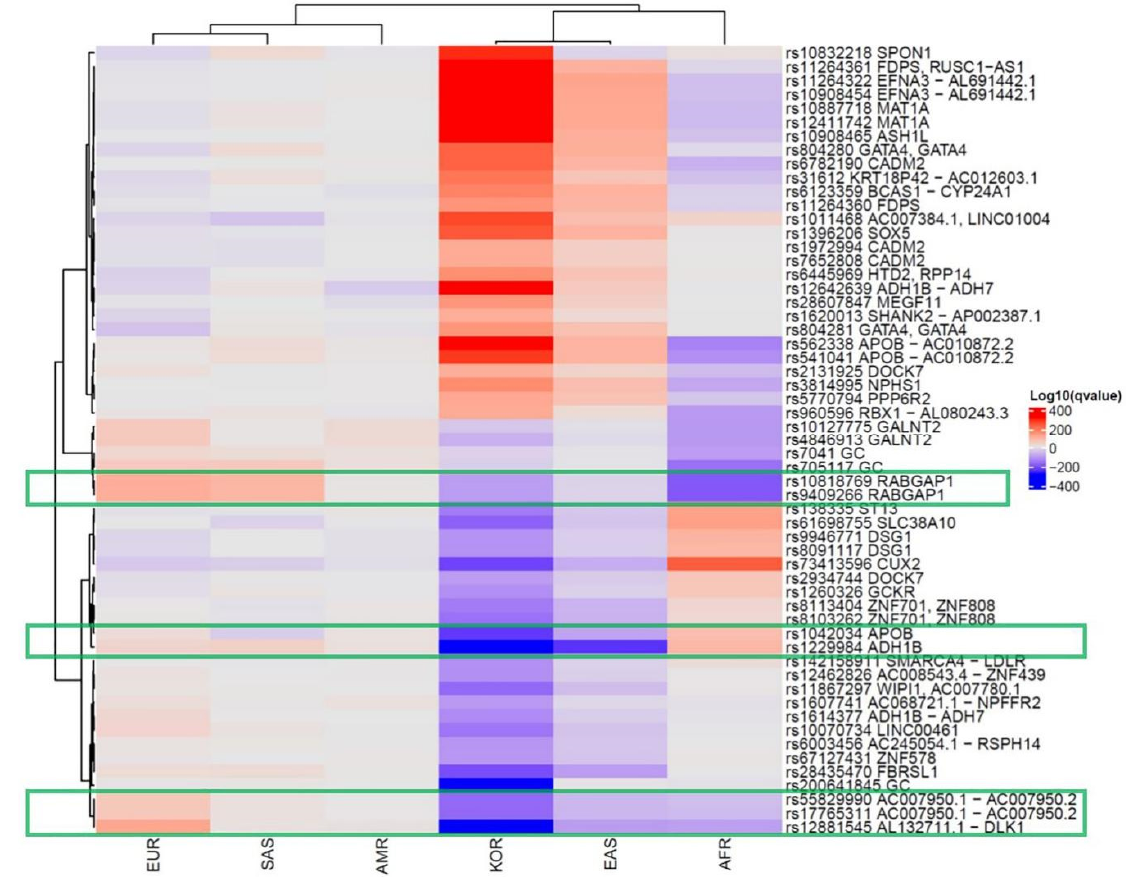
Figure 1. Significant single-nucleotide polymorphisms related to the vitamin D concentration in the global population. Each row shows an SNP, and each column is a population group. The red color indicates enrichment of the effect allele, whereas the purple color indicates the depletion. The following SNPs ((rs10818769 and rs9409266 ( RABGAP1 ) in the red box, followed by rs12881545 ( DLK1 ), rs10070734 ( LINC00461 ), and rs17765311 ( AC007950.2 )) were highly depleted in East Asians (including Koreans) and Africans and were enriched in Europeans. (AMR: American, EUR: European, SAS: South Asian, AFR: African, EAS: East Asian, KOR: Korean.).